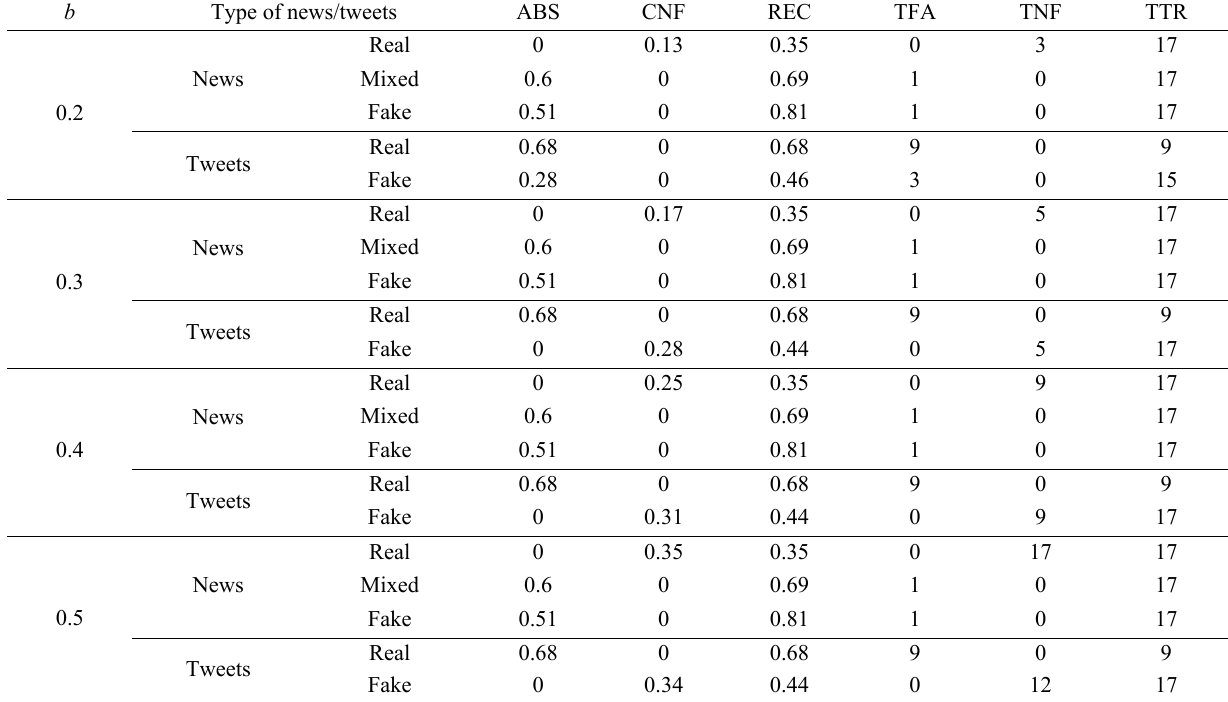
Table 6 Absorption (ABS), community non-functioning (CNF), recovery (REC), time for absorption (TFA), time under community non-functioning (TNF), and time to recovery (TTR) for news and tweets with the critical community functionality threshold b varying over the type of new/tweets range of